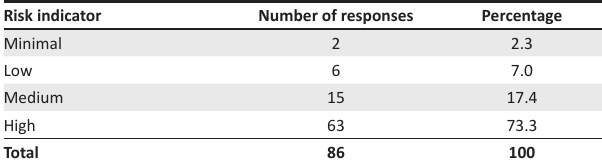
TABLE 2: Perception of threat of disasters.